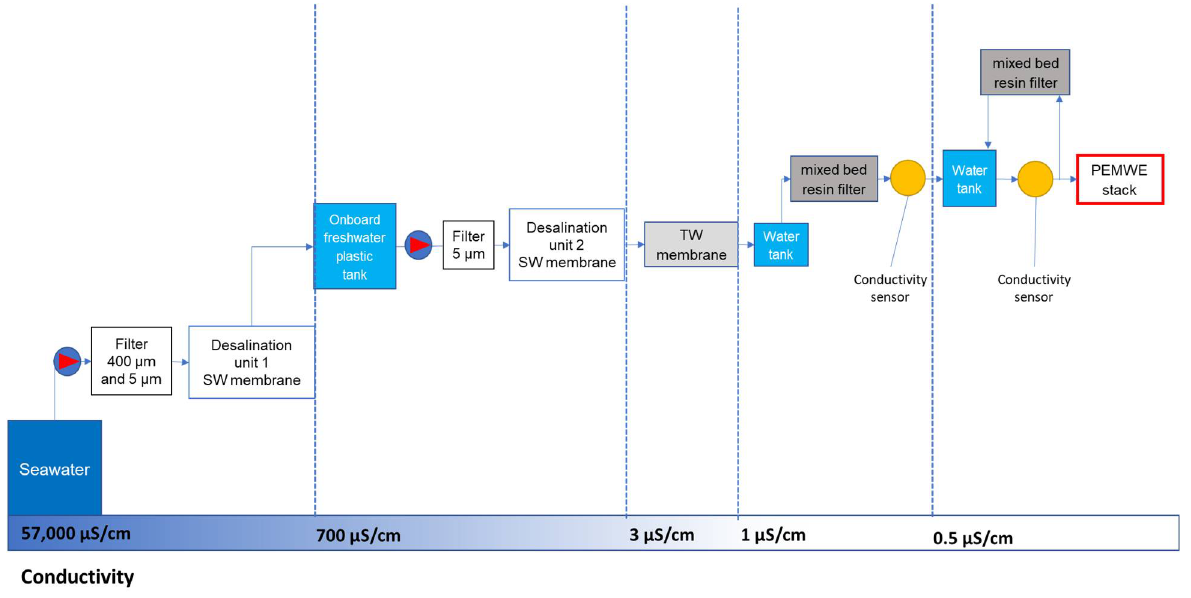
Figure 2. Schematic of the seawater purification system from seawater down to deionised water used to feed the PEMWE. An approximative conductivity value is presented for each step of the processes.